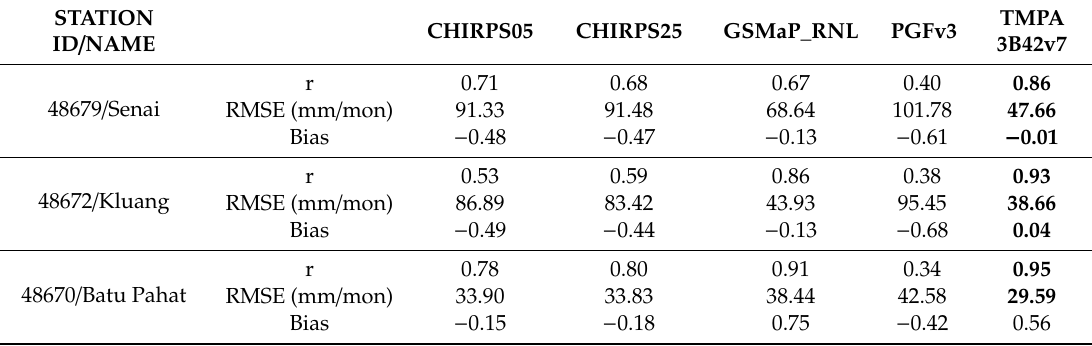
Figure 8. Time series of daily rainfall for six rain gauge stations during the 2006/2007 flood event. Table 7. Performance measures of CHIRPS05, CHIRPS25, GSMaP_RNL, PGFv3 and TMPA 3B42v7 in affected stations during flood event 2006/2007. The best values are in bold.